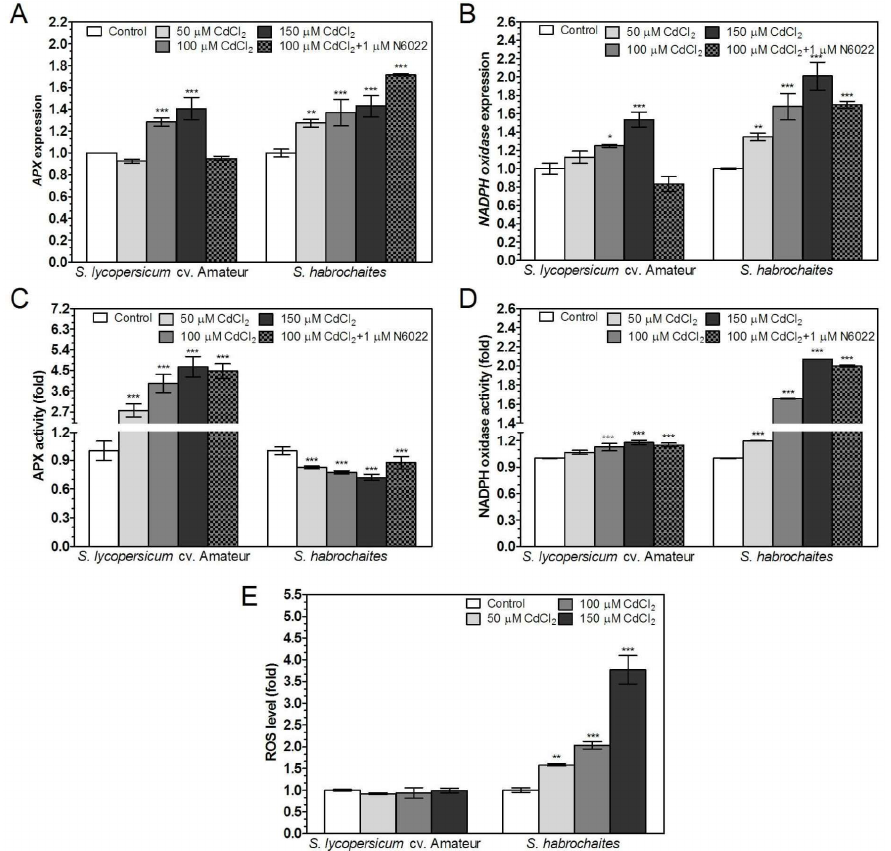
Figure 6. APX and NADPH oxidase gene expression, enzyme activity and ROS levels in two Solanum spp. genotypes exposed to cadmium stress. Relative APX and NADPH oxidase gene expression in plant roots exposed to 50, 100, 150 µ M CdCl 2 or combination of 100 µ M CdCl 2 with 1 µ M N6022 was determined by qPCR. ( A ) APX and ( B ) NADPH oxidase expression levels were normalized to GAPDH and EF1 α mRNA levels. ( C ) APX activity was evaluated spectrophotometrically at 25 ◦ C by monitoring the consumption of H 2 O 2 at λ = 290 nm. ( D ) NADPH oxidase-catalysed O 2 − generation in purified membrane fractions from tomato roots was determined spectrophotometrically at 25 ◦ C by reduction of the tetrazolium salt XTT. ( E ) Quantification of detected ROS levels in the root apical parts by confocal microscopy using 20 µ M H 2 DCF DA (Supplementary Figure S7) was performed by ImageJ 1.33 software. The data are presented as means ± SD ( n ≥ 3) relative to the gene expression levels or signal intensities measured for control grown without cadmium. Significantly di ff erent means from the control are denoted by asterisks (ANOVA, * p < 0.05, ** p < 0.01, *** p < 0.001).